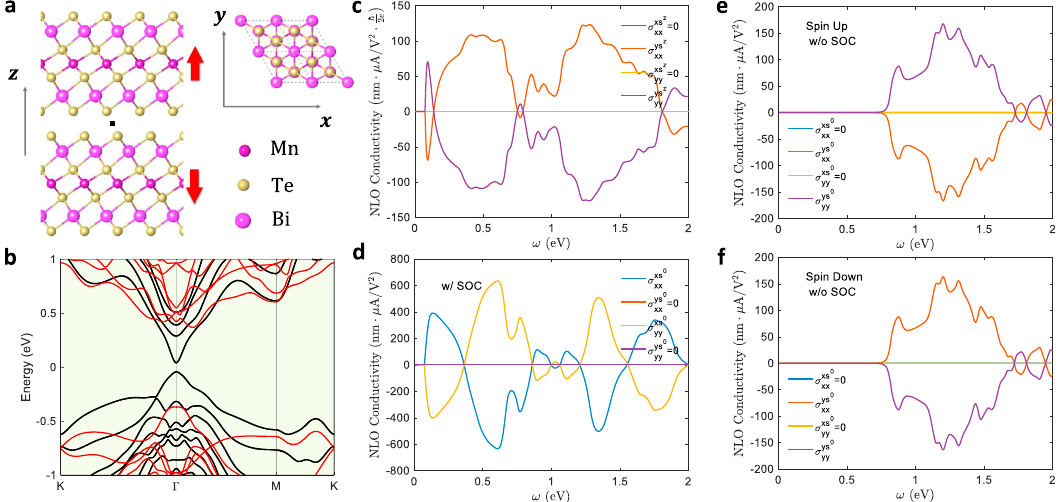
Fig. 3 NLO spin current of MBT. a Atomic structure of bilayer MnBi 2 Te 4 . The atomic structure has both inversion symmetry P and mirror symmetry M x . The inversion center is in between the two layers (black square). The magnetic momentum on Mn is indicated by the red arrows. Considering magnetism, both P and M x break. b Band structure of MBT with (black) and without (red) SOC. c , d The NLO spin and charge photoconductivity of bilayer MnBi 2 Te 4 with SOC. Both spin and charge currents have nonzero components and exhibit complementary behavior. e , f The NLO charge conductivity without SOC. The spin-up and spin-down states are treated separately. The photoconductivity from spin-up and spin-down states are exactly opposite to each other. Therefore, the total charge conductivity is zero. But the spin- z conductivity is